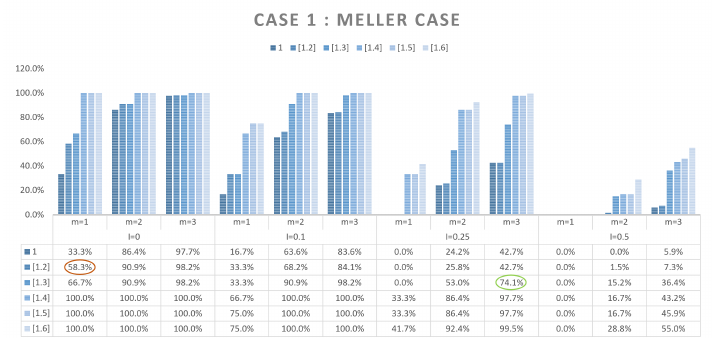
Figure 9. Histogram of the solutions number per range—Meller’s scenario.